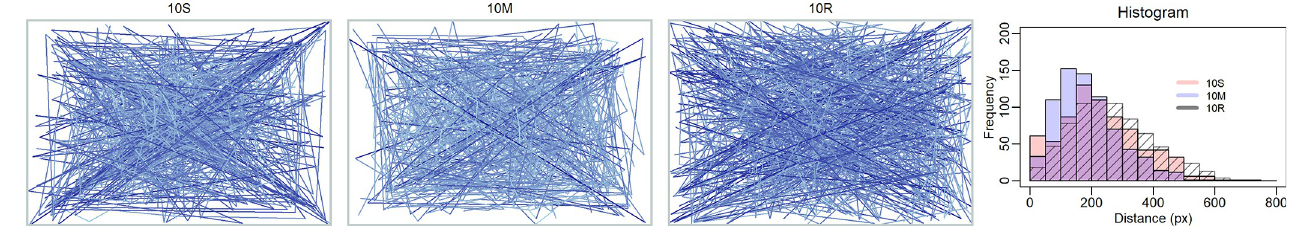
Fig 10. Line patterns resulting from connecting successive dots for each participant in the two conditions in Experiment 3, and for the random-dot pattern (10R). The blue gradient indicates the length of the lines: The longer the line the darker the blue. The corresponding histograms are shown in the outermost panel on the